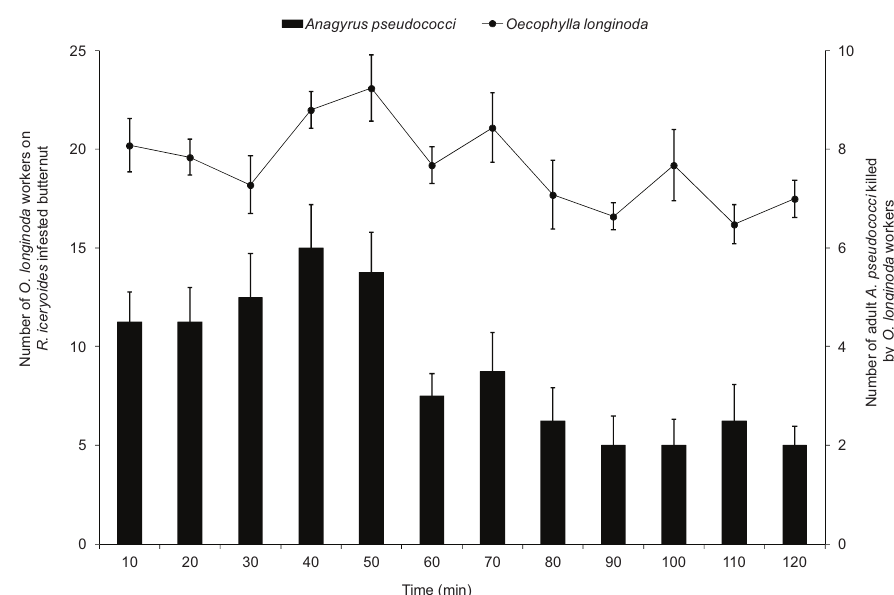
Figure 4. Mean (±standard error) number of Oecophylla longinoda on Rastrococcus iceryoides -infested butternuts and mean number of adult Anagyrus pseudococci killed by Oecophylla longinoda workers in the foraging cages at 10 min intervals over a 2 h observation period.